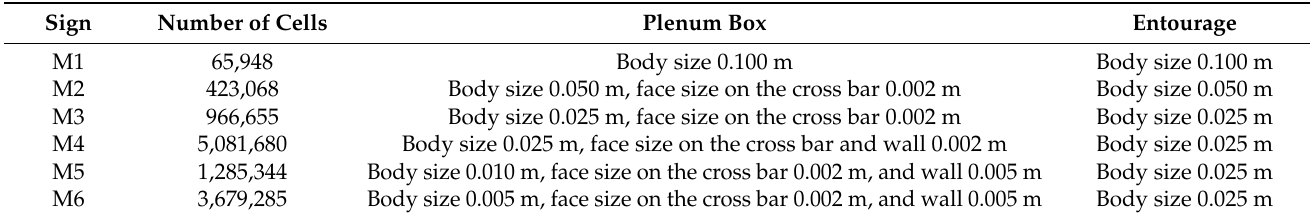
Table 1. Summary for meshes used in